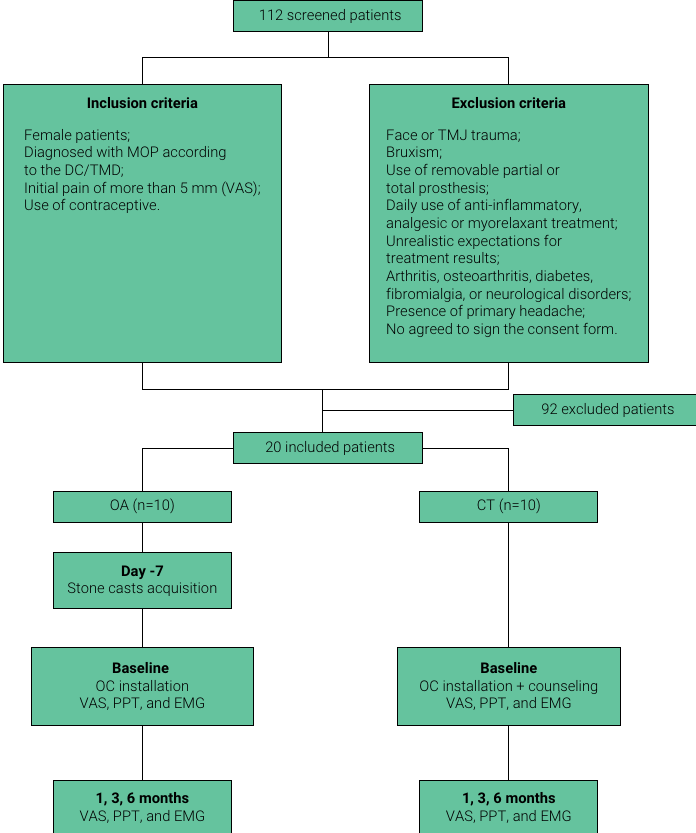
Figure 1. Flowchart of the study showing the screened patients, inclusion and exclusion criteria, enrolled patients, and sequence of treatments application and